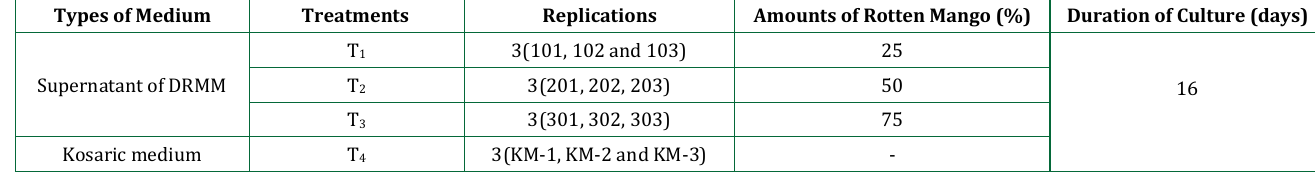
Table 1 : Experimental Design for S. Platensis Culture Using Supernatant of Three Different Concentrations of Digested Rotten Mango. Types of